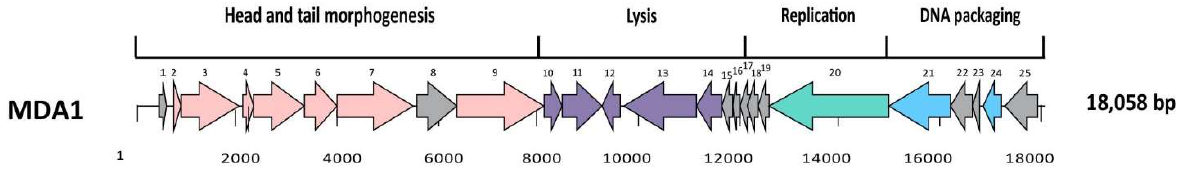
Figure 2. Genome structure of MDA1 phage. Each arrow represents an ORF. Colors represent different genomic regions including the DNA packaging (blue), the head and tail morphogenesis genes (pink), host lysis genes (purple), and the replication–transcription region (green). Grey arrows represent genes coding for hypothetical proteins.